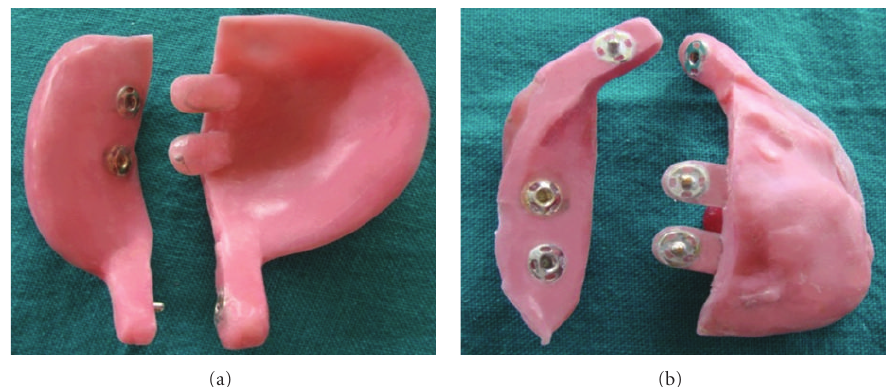
Figure 9: (a) and (b) Showing anterior and posterior locking mechanism.